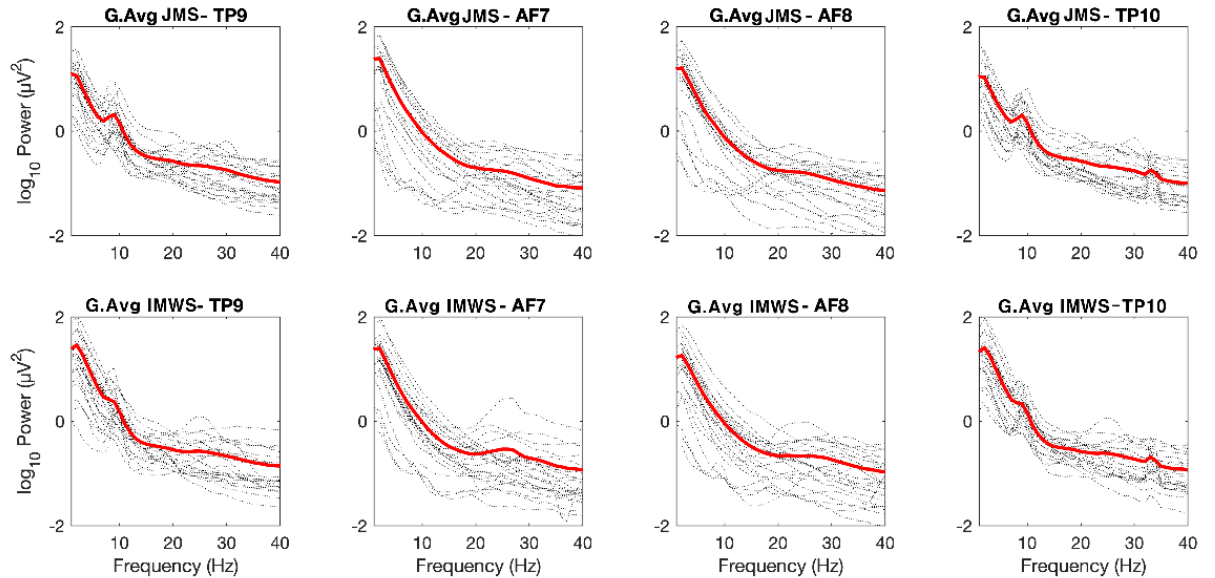
Figure 3. Frequency analysis grand average. G: grand, Avg: average. JMS: Juingong meditation state, IMWS: IMW state, Hz: Hertz TP: temporoparietal, AF: anterior frontal. In accordance with the international 10–20 system, the odd-numbered channel is placed on left side, the even-numbered channel is placed on the right.